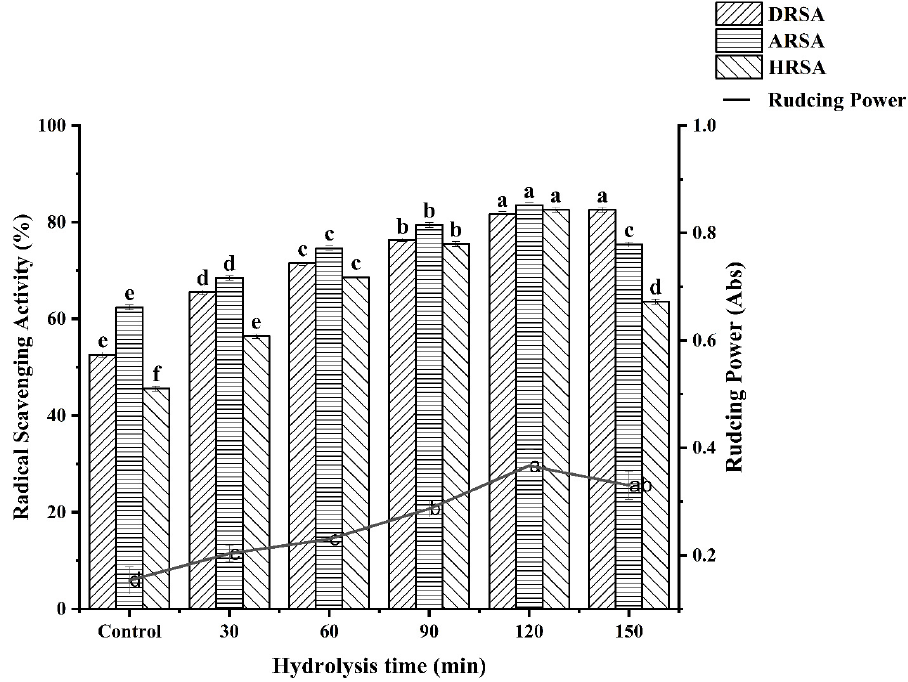
Figure 6. Determination of antioxidant activity at different hydrolysis times. Different letters indicate a significant difference ( p < 0.05).